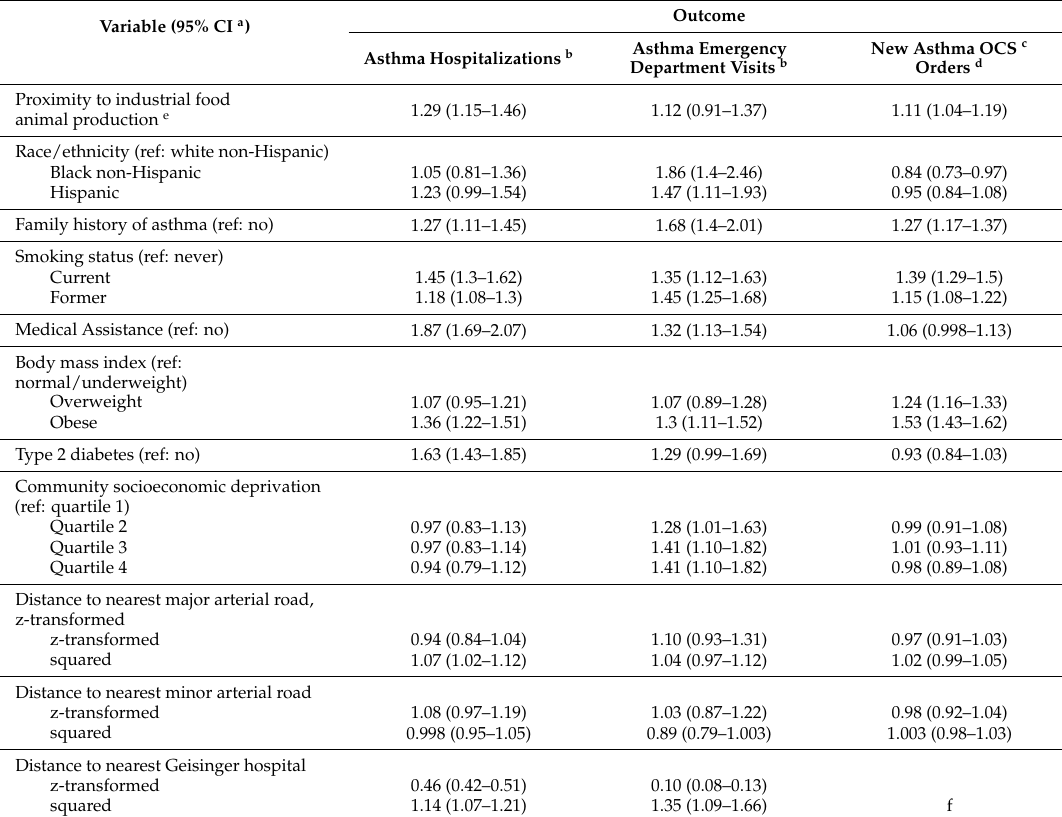
Table 3. Associations of proximity to industrial food animal production (defined as a facility within 3 miles of home address) and asthma exacerbation